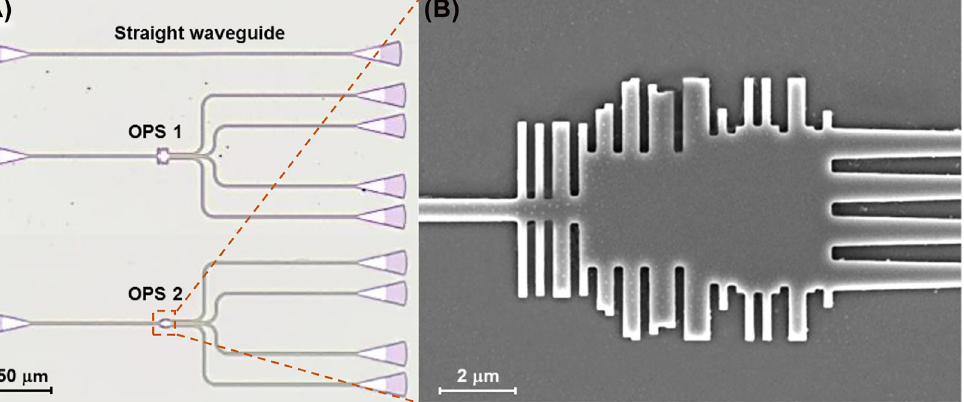
Figure 4: Images of the fabricated devices. (A) An optical microscopic image of the straight waveguide, OPS 1, and OPS 2, (B) SEM image of OPS 2